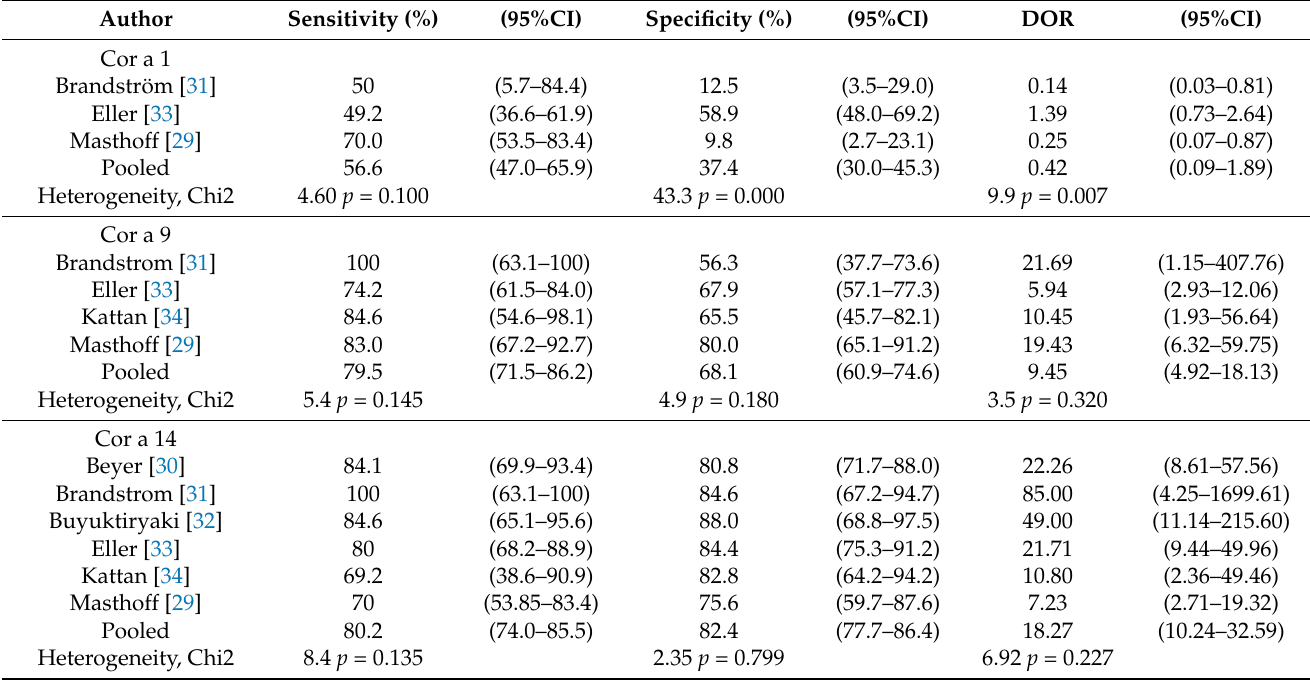
Table 2. Diagnostic accuracy of sIgE to Cor a1, Cor a9, Cor a14. DOR = diagnostic odd